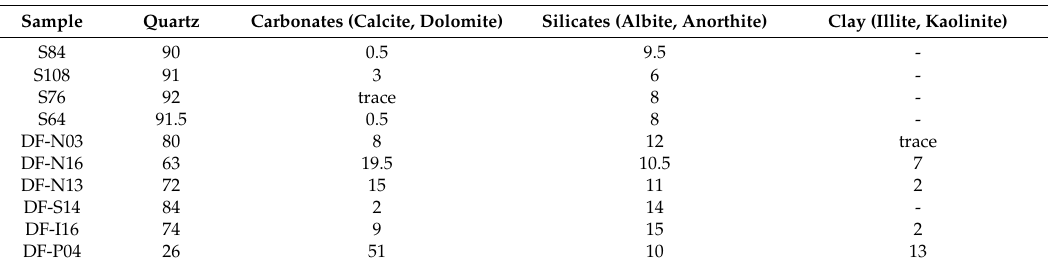
Table 1. Mineral content (%) of the collected samples according to the XRD analysis.